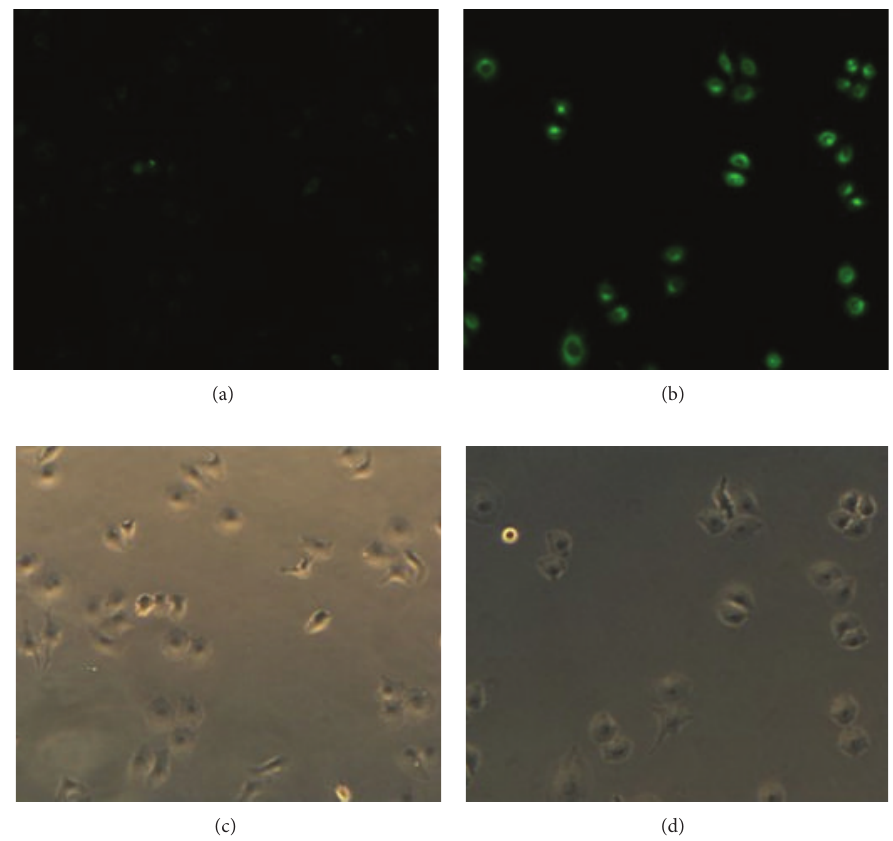
Figure 8: The fluorescence microscopy images and white light microscopy images of HepG2 cells after 6h incubation with different coumarin loaded micelles: the Chol-M-Cou ((a) and (b)); the GA-M-Cou ((c) and (d)).